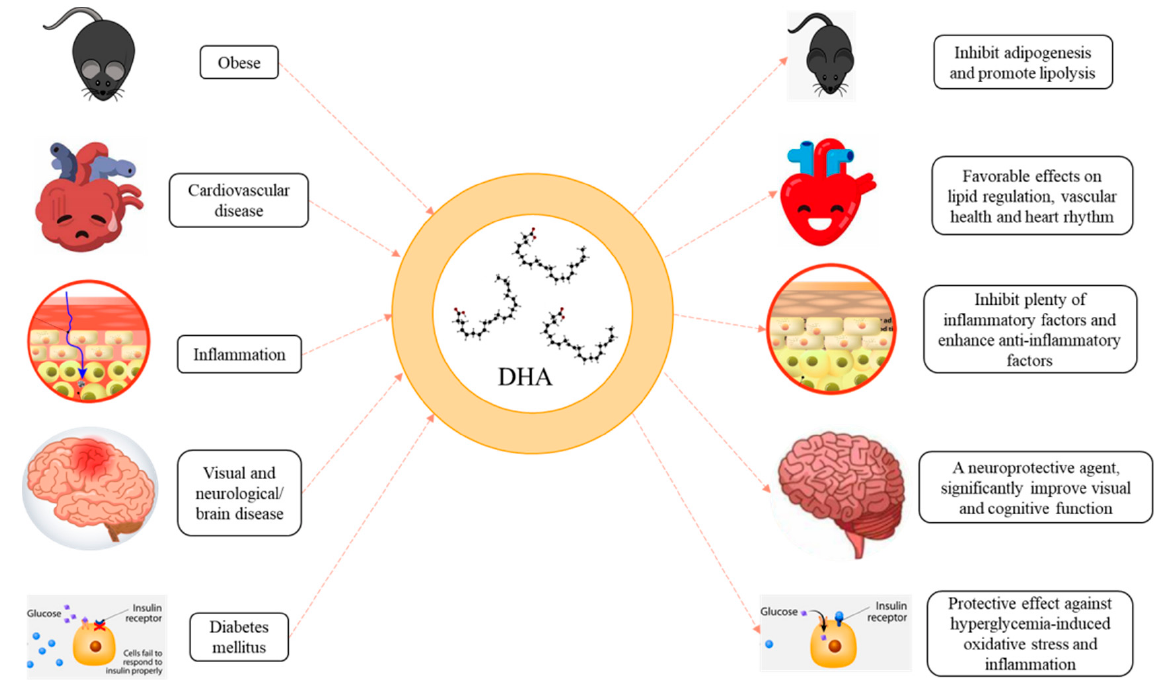
Figure 5. Functionality of DHA in delivery systems.